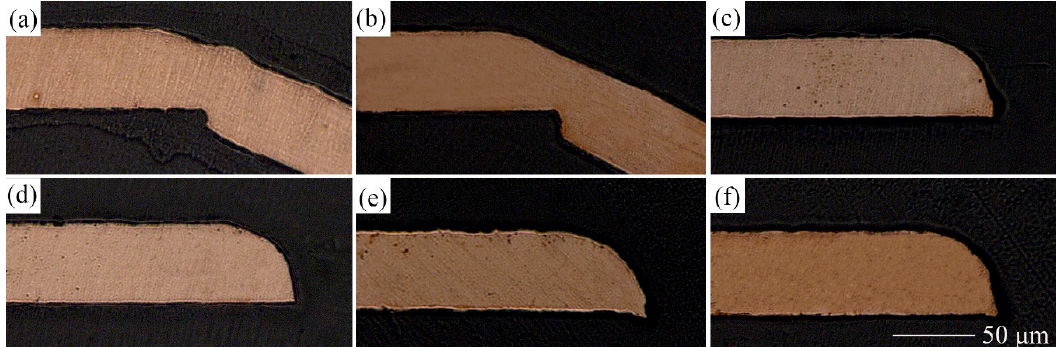
Figure 9. Section morphology of punched parts without LPS under different laser power densities.